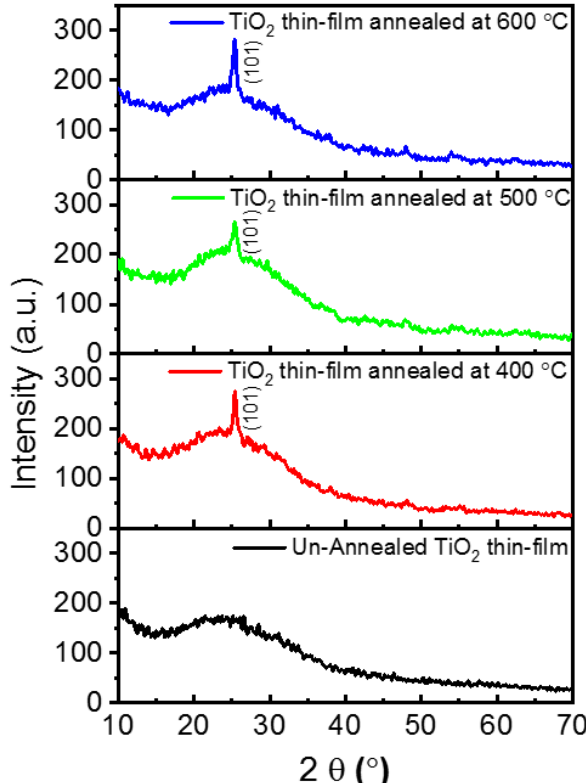
Figure 1. Grazing Incident X ‐ ray Diffraction (GIXRD) patterns of TiO 2 thin films post ‐ annealed at different temperatures.